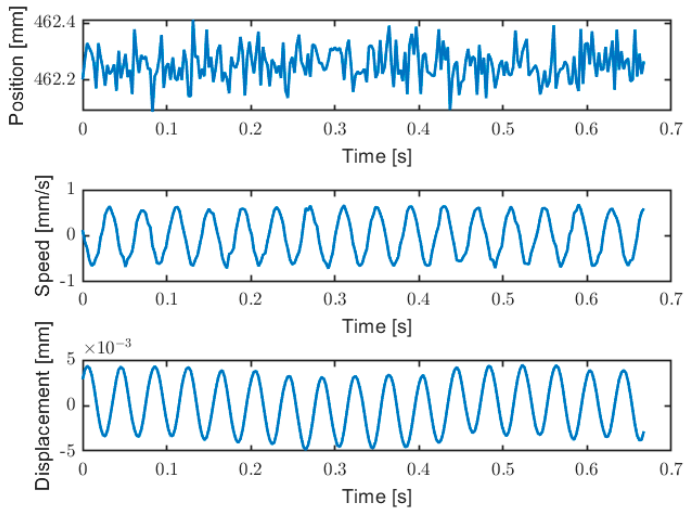
Figure 15. Example of vibration measurement. Upper trace is the absolute distance measurement; middle trace is the measured target speed (Doppler shift); lower trace is the reconstructed target vibration, by integration of the speed measurement.